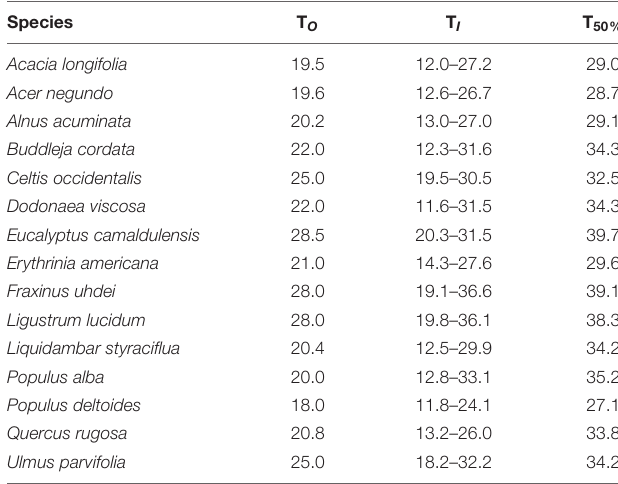
TABLE 3 | Optimal temperature (T O , ◦ C), optimal thermal interval (T I , ◦ C), and maximum temperature when stomatal conductance decreased by 50% (T 50% , ◦ C) for the stomatal function for 15 tree species from Mexico City’s urban